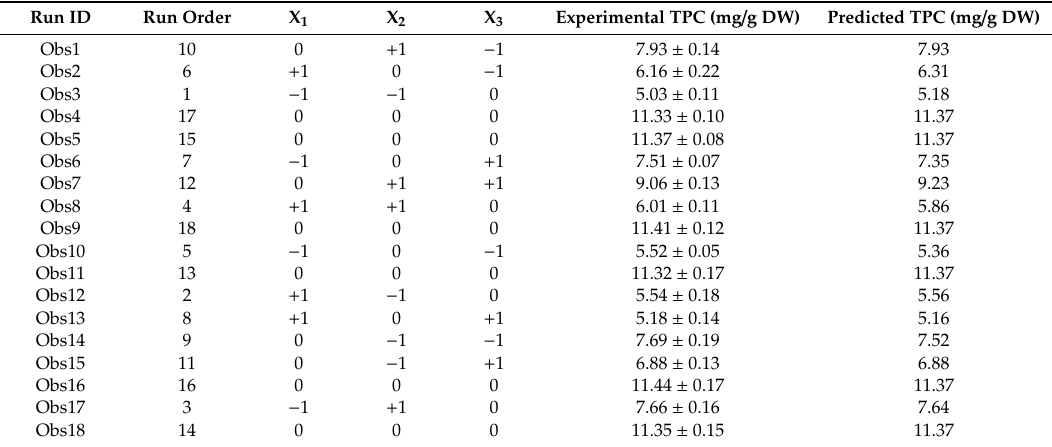
Table 2. Results of Box–Behnken experimental design of USAE of TPC from